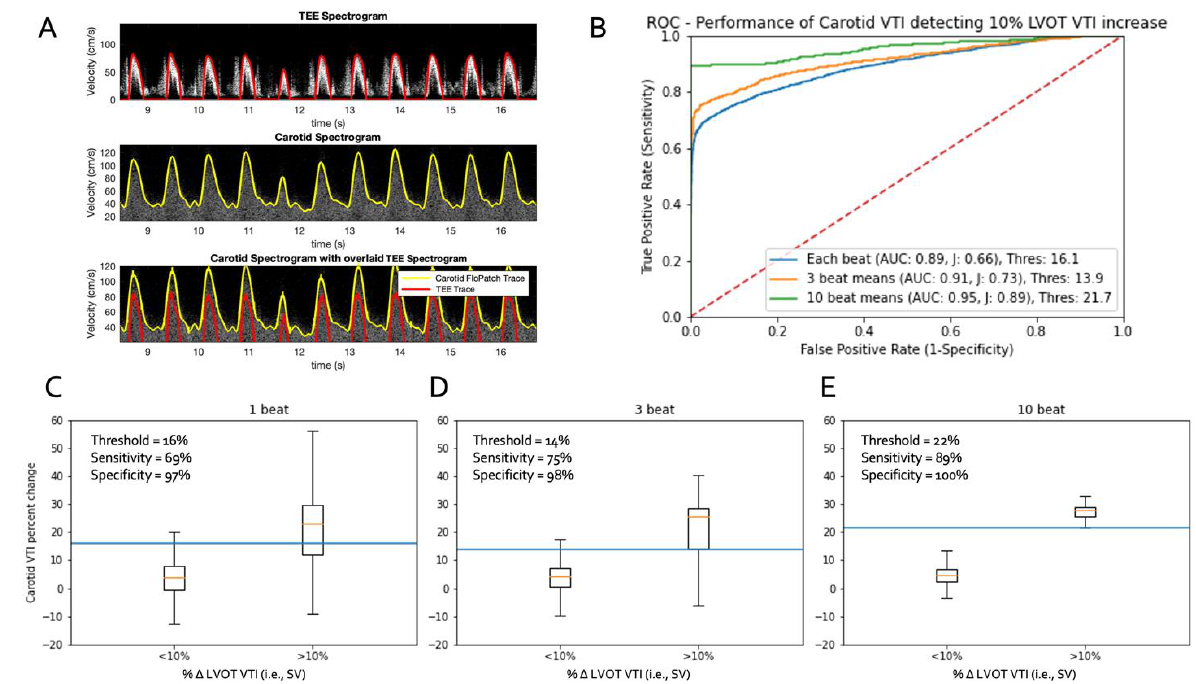
Figure 2. Results from the proof-of-principle study. ( A ) Simultaneously acquired Doppler spectra from the wearable Doppler and the trans-esophageal echocardiogram (TEE) during arrhythmia from one of the studied patients. ( B ) shows the area under the receiver operator curves for beat-to-beat, 3 consecutively averaged and 10 consecutively averaged cardiac cycles for the two patients. ( C – E ) shows the boxplots and optimal ccVTI ∆ thresholds for discriminating +10% SV ∆ from <10% SV ∆ across the different degrees of consecutive beat averaging.